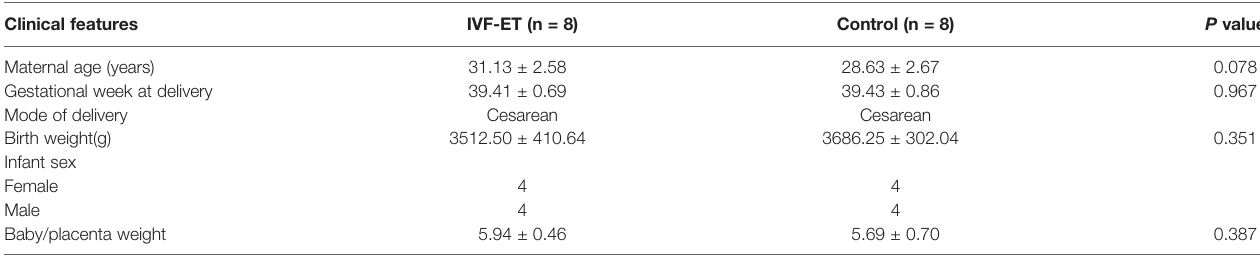
TABLE 2 | Clinical characteristics of IVF-ET and controls. Clinical features